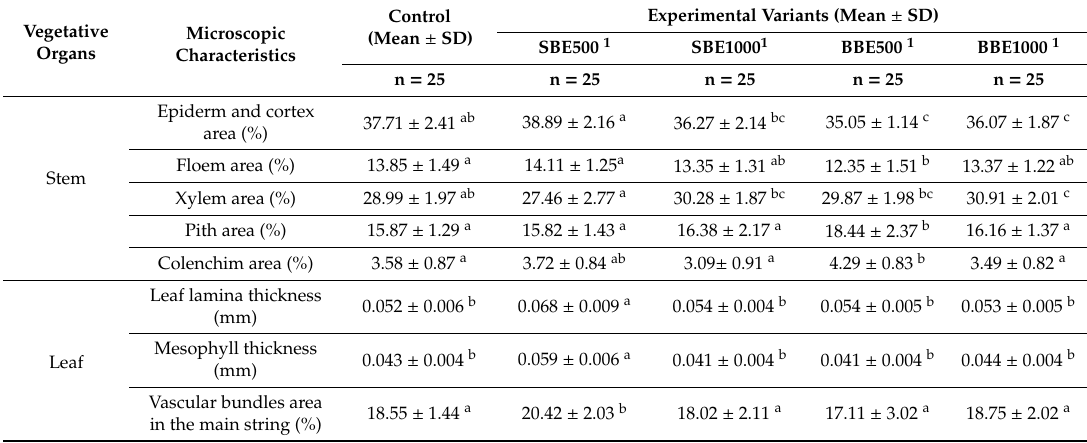
The microscopic characteristics of vegetative organs in case of treated and control lavender